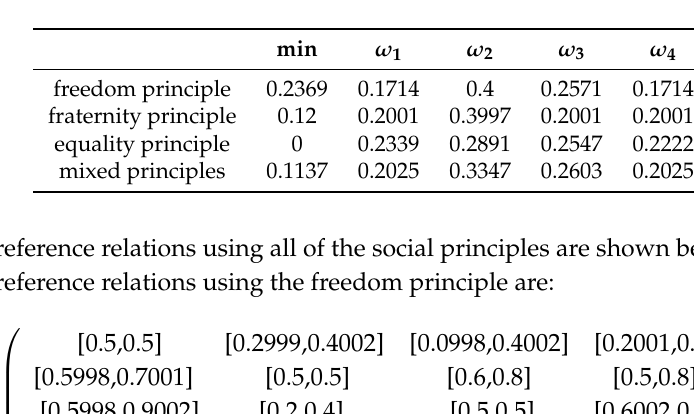
Table 2. Results of the model with II